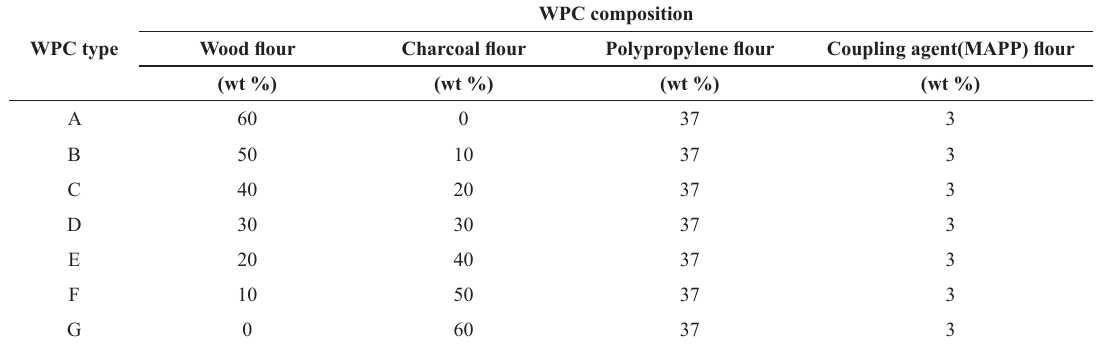
Table 1. Experimental